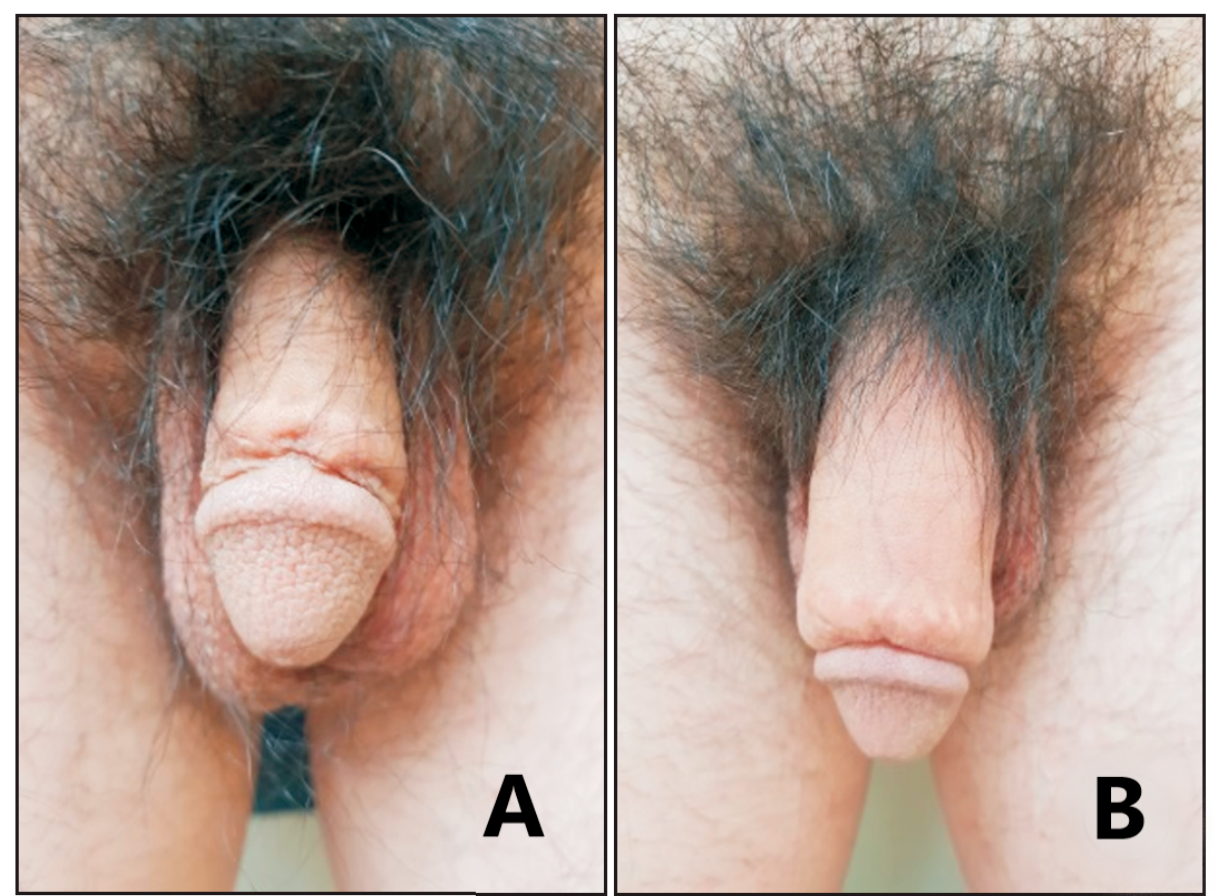
Figure 1. Penile girth enhancement using a HA filler. Penile appearance before injection ( A ) and after injection ( B ). Images reused from Ahn et al. [18], which is distributed under the terms of the Creative Commons Attribution Non-Commercial License (http://creativecommons.org/licenses/by-nc/4.0, accessed on 25 January Table 1. Studies dealing with the use of HA for penile enlargement purposes.